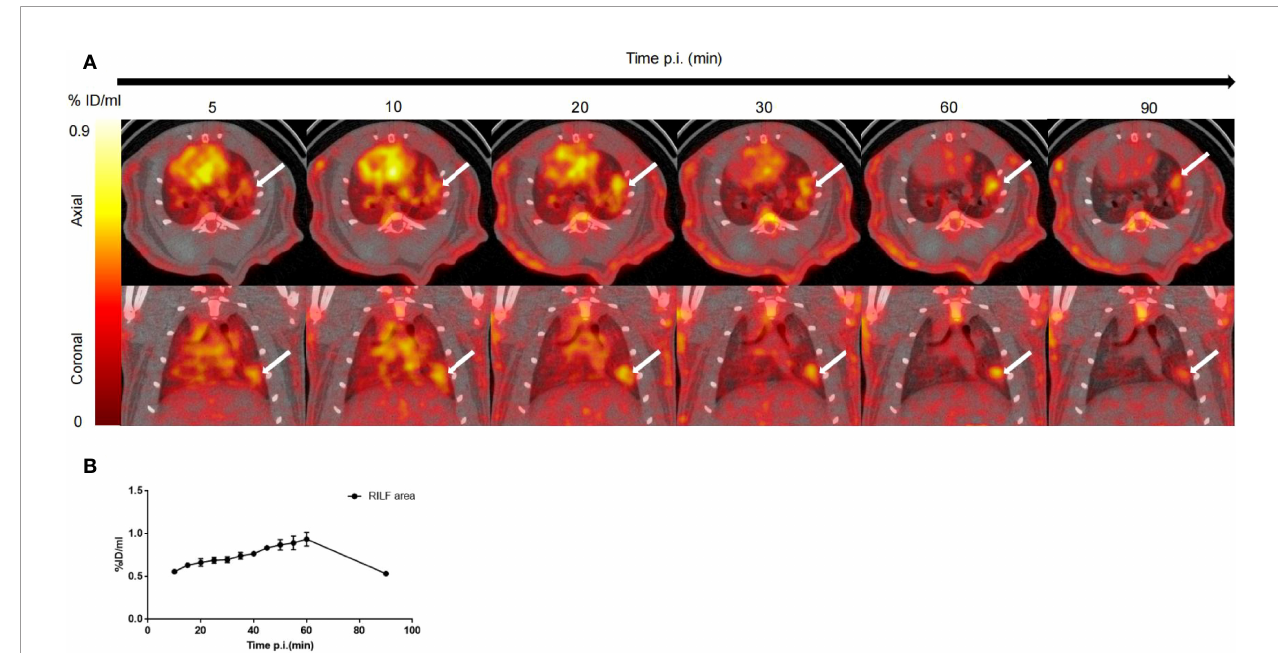
FIGURE 3 | In vivo dynamic imaging of 18 F-NOTA-FAPI uptake in irradiated rat lung tissue. (A) Serial PET/CT images (axial and coronal sections) from 90 min of dynamic scanning. White arrows indicate area of RILF. (B) Corresponding time – activity curves for fi brosis in lung tissue (average and SD, n=3). p.i. =